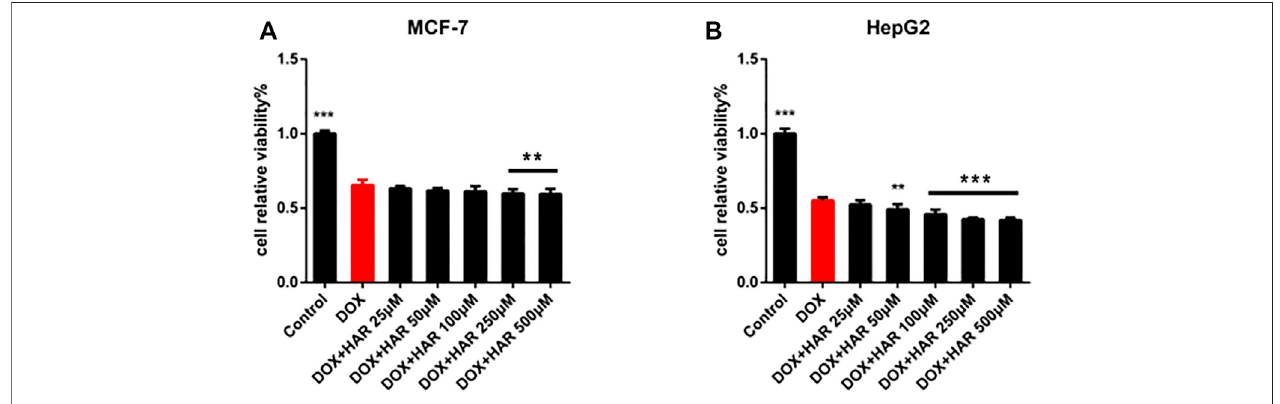
FIGURE8| HARplayedaprotectiveroleintheheartwithoutinterferingwithantitumoureffectofDOX. (A,B) Thein fl uenceofHARontheanticancereffectofDOXon MCF-7 and HepG2 cells was determined by CCK-8 assay ( n = 6). * p < 0.05, ** p < 0.01, *** p < 0.001 vs. DOX group. The data are shown as the mean ± s.d.